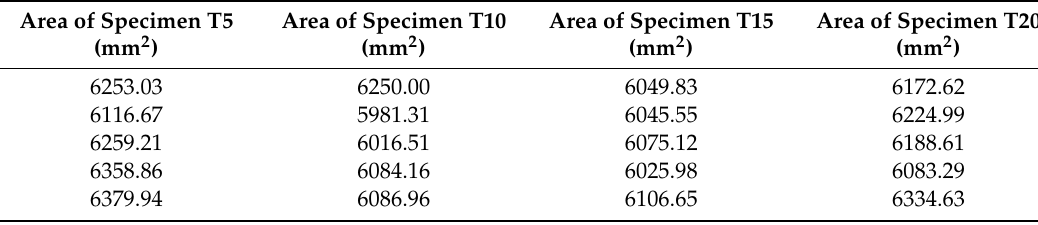
Table 3. Nominal area of the interface section of each specimen.